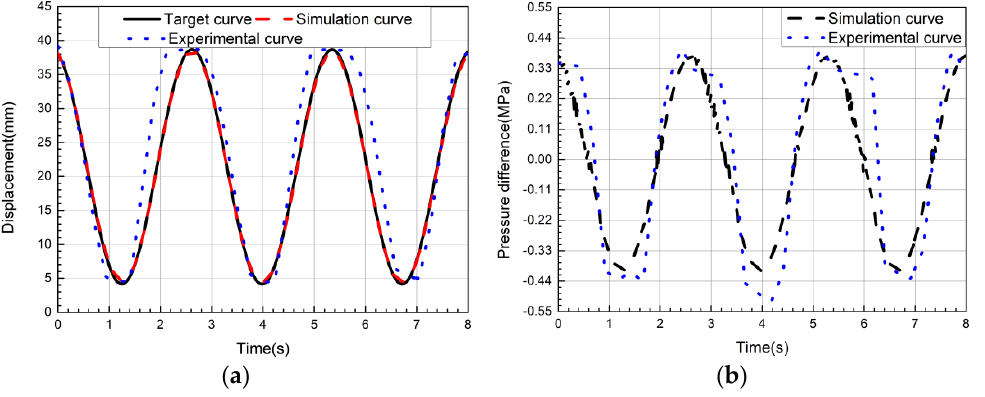
Figure 20. Sine signal position control graph: ( a ) Displacement graph; ( b ) The differential graph.